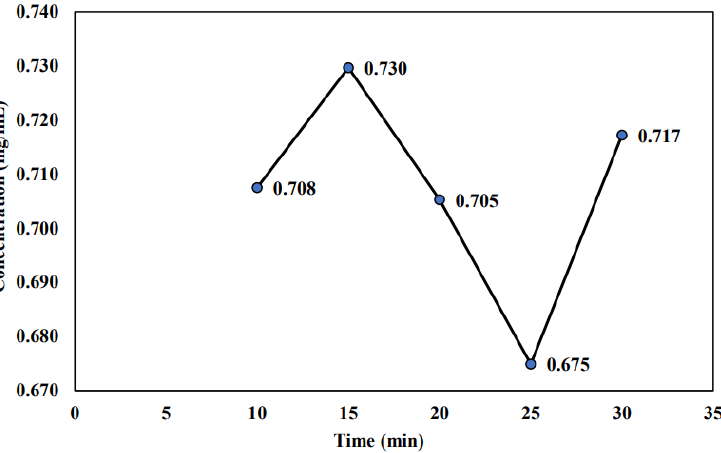
Figure 6. Saponin concentration of sterilized sample at different concentration times.